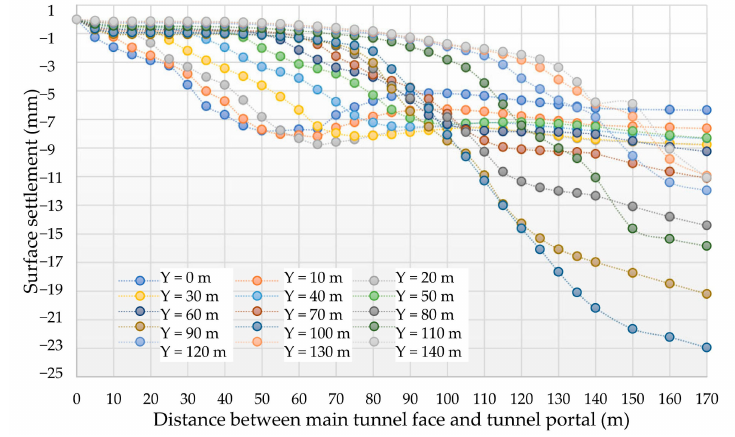
Figure 16. Surface settlement during excavation of the main